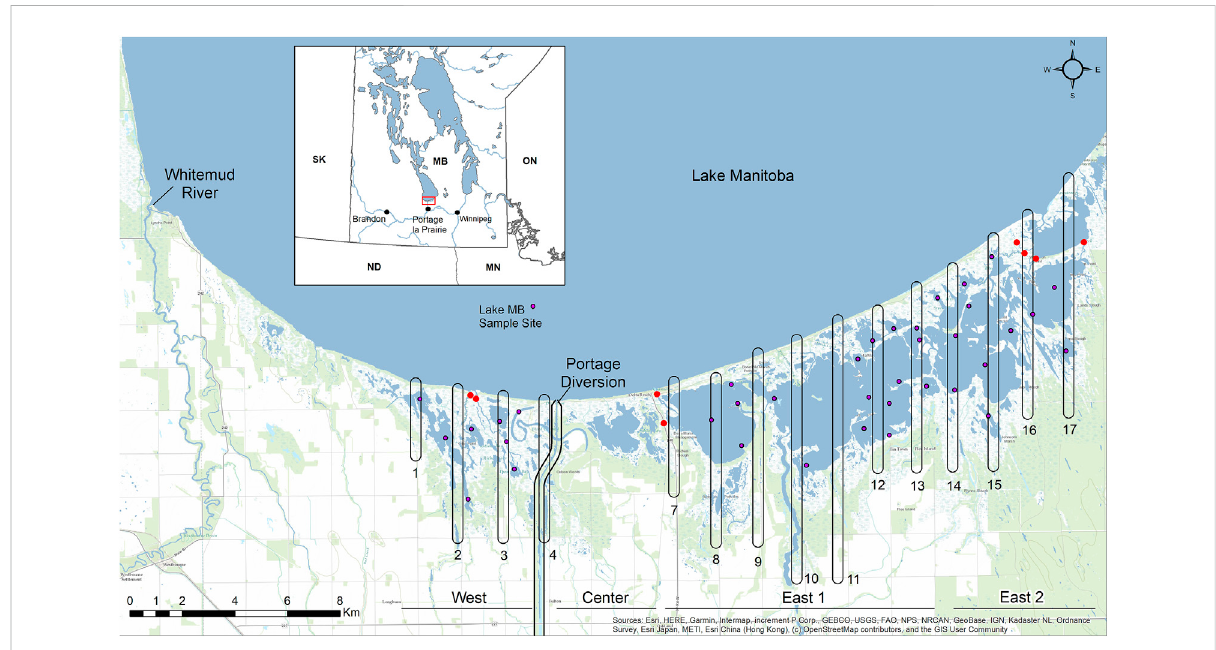
FIGURE 1 Location of water clarity sampling sites(purpledots)in thewest, east 1,and east 2 units atDelta Marsh(37), and atLake Manitoba (1).Red circles are locations of carp exclusion structures; numbered rounded rectangles are submersed aquatic vegetation mapping transects. The inset fi gure shows the location of Delta Marsh (red bounding box) within